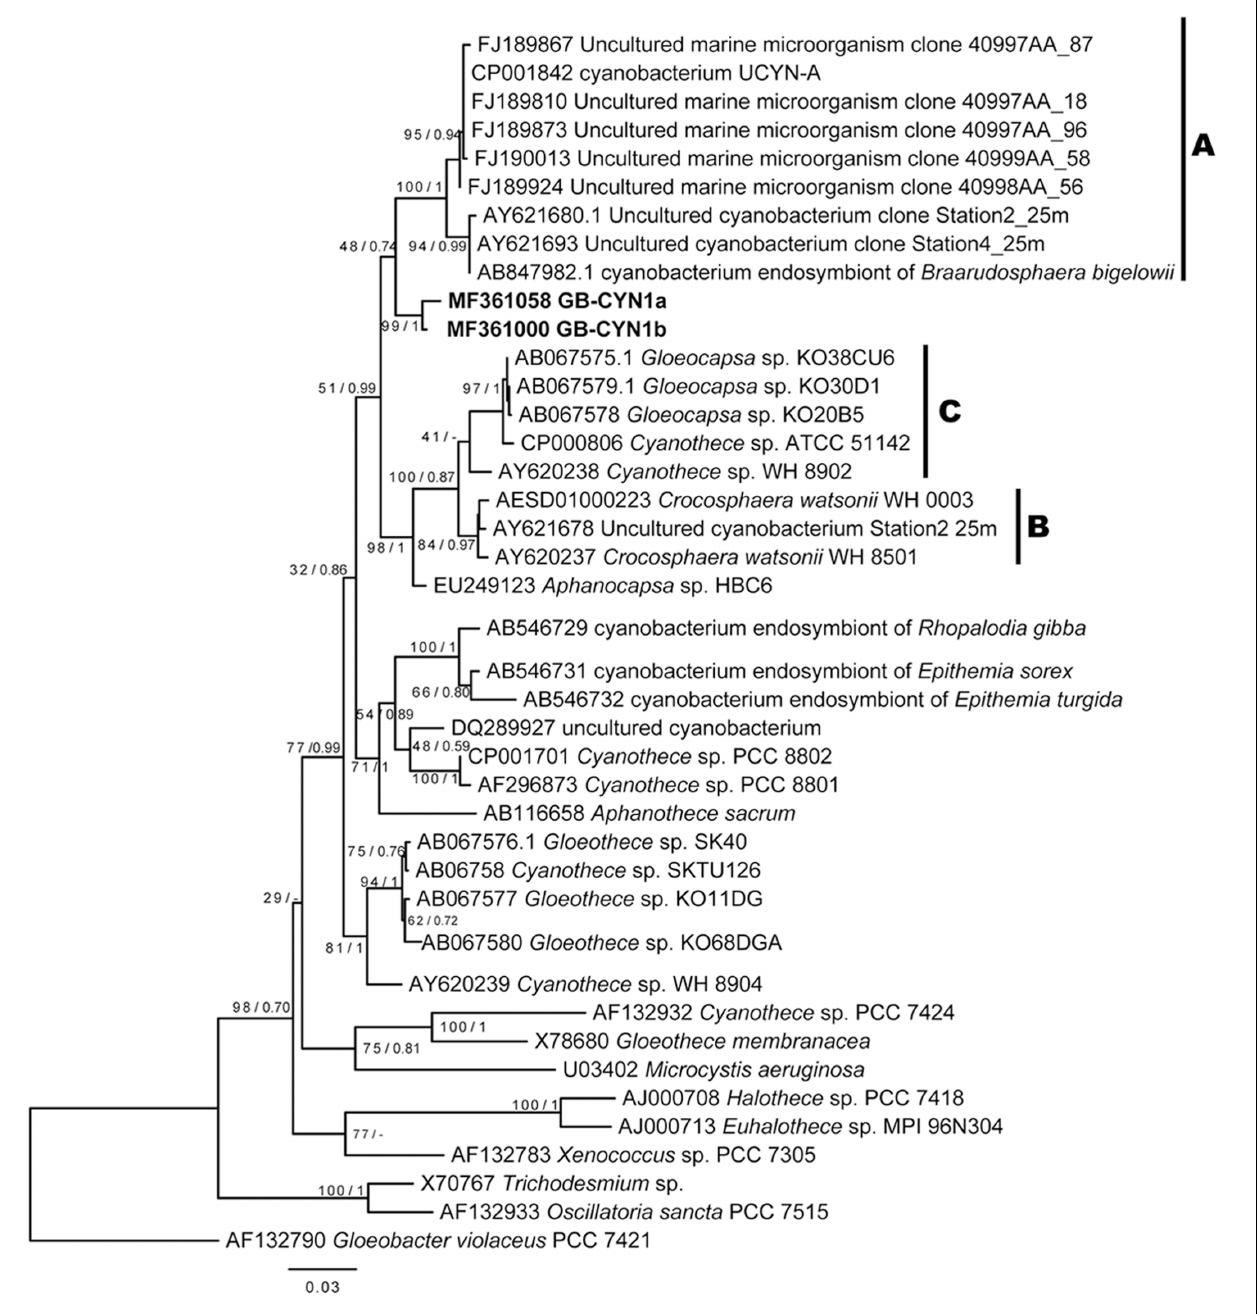
FIGURE 3 | Maximum likelihood and Bayesian 16S rRNA gene phylogenies of GB-CYN1 species and related cyanobacteria. Reference sequences were full length and GB-CYN1 OTUs (bold) were partial ( ∼ 700–800 bp). Constructed from (A) 16S rRNA sequences from (partial sequences, ∼ 700–800 bp, bold) and Numbers at the nodes indicate bootstrap values from maximum likelihood analysis (1000 replicates) and the posterior probability of the Bayesian tree inference. The Bayesian consensus tree was concordant with maximum likelihood tree topology except where indicated by a dash. Scale bar represents the mean number of nucleotide substitutions per site. The major clades of unicellular cyanobacteria (UCYN-A-C) are labeled according to (Zehr et al., 2001; Langlois et al., 2005; Foster et al., 2007).